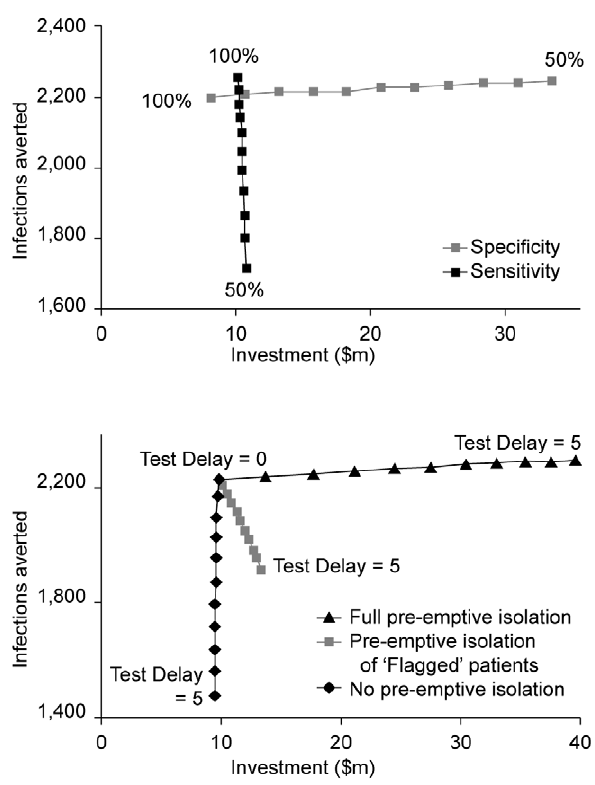
Figure 4. Results of the sensitivity analysis of test character- istics. The costs of selective PCR-based screening are depicted on the horizontal axis and health benefits (infections averted) on the vertical axis. The left graph shows the combined results of alternately varying the test’s sensitivity and specificity from 50% to 100%, with increments of 5%. The right graph shows the test delay varied from 0 to 5 days, with increments of 0.5 day, for different pre-emptive isolation strategies: No pre-emptive isolation (diamonds), pre-emptive isolation of ‘flagged’ patients only, i.e. the base-case scenario (squares), and full pre-emptive isolation, i.e. ‘flagged’ patients as well as ‘high risk’ patients (triangles).